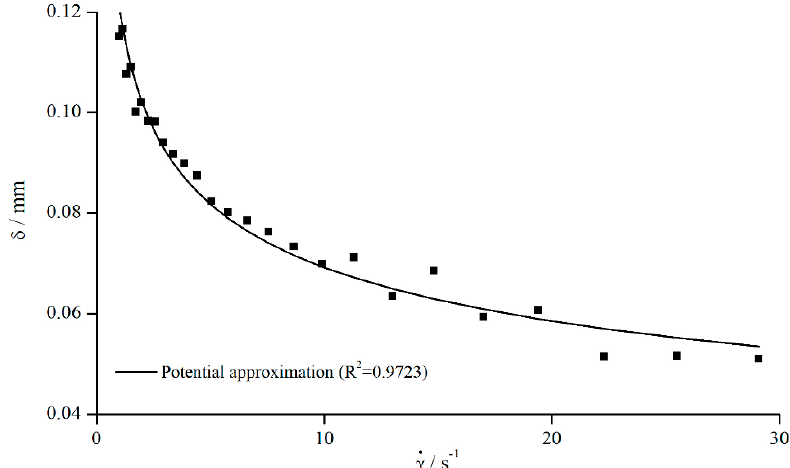
Figure 15. Effective gap extension 𝛿 (gap- and material-averaged) dependent on the shear rate of 1 wt. % xanthan gum solution obtained for columns (system 6, 𝐻 = 1 mm ). 1 wt. % xanthan gum solution obtained for columns (system 6, H = 1